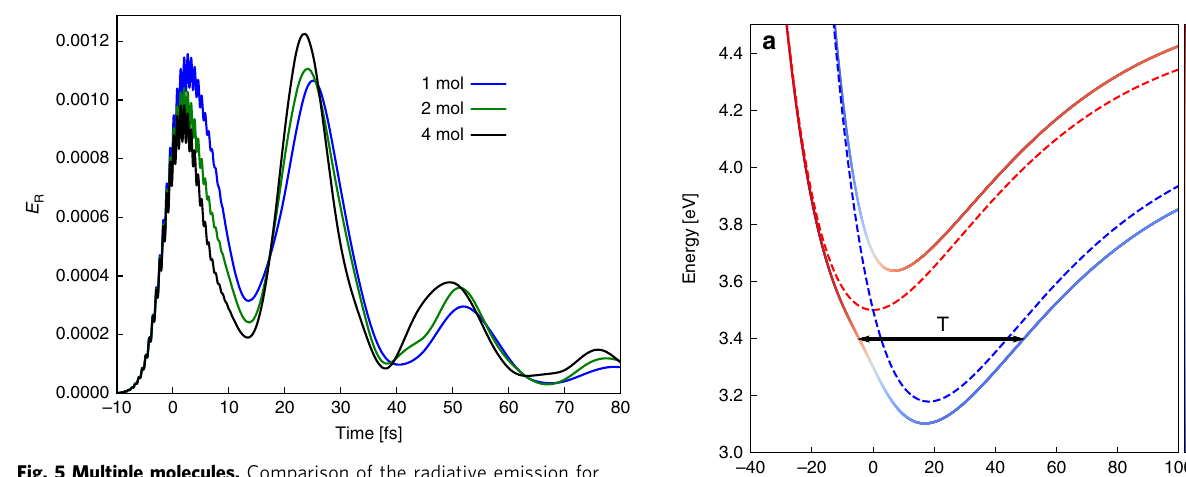
ffiffiffiffi p / N fi xed. The blue, R